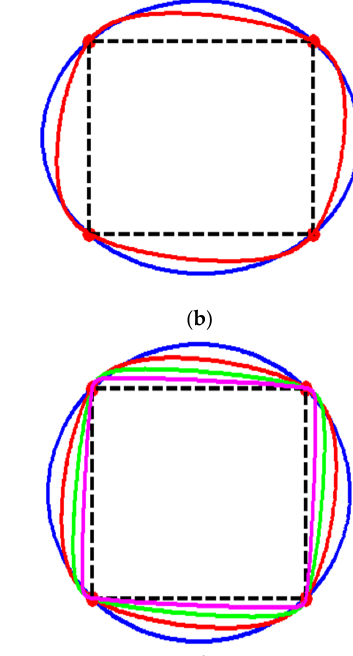
= 2, 3, 5, and 10 ∀ i i